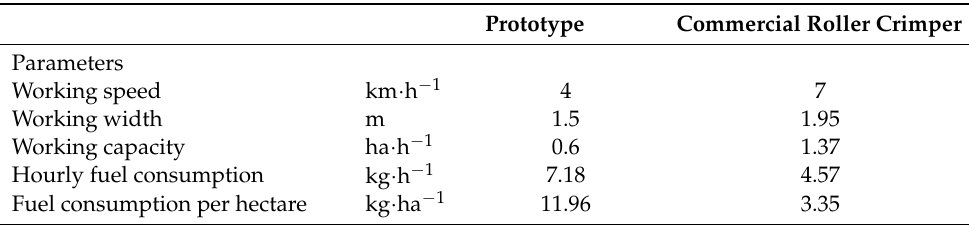
Table 4. Operative characteristics of the prototype and the commercial roller